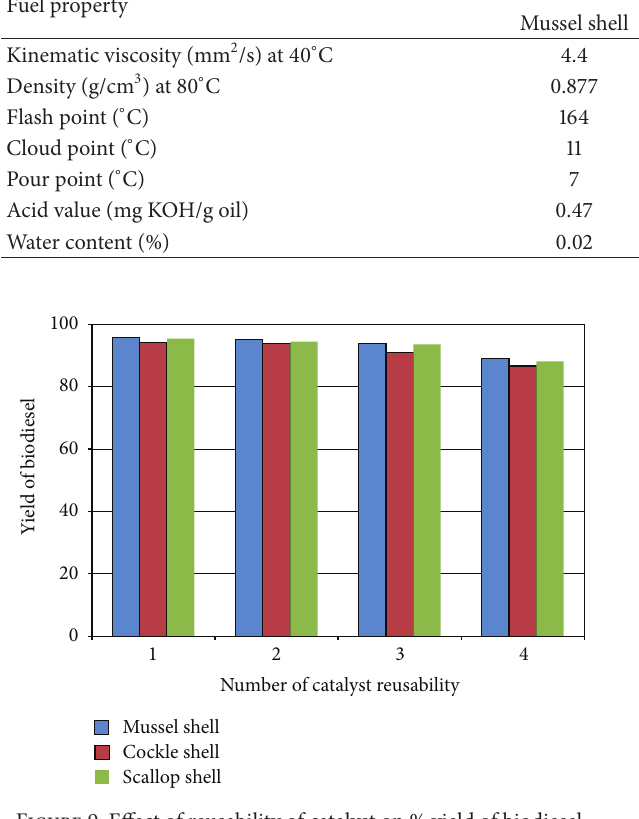
Figure 9: Effect of reusability of catalyst on % yield of biodiesel.